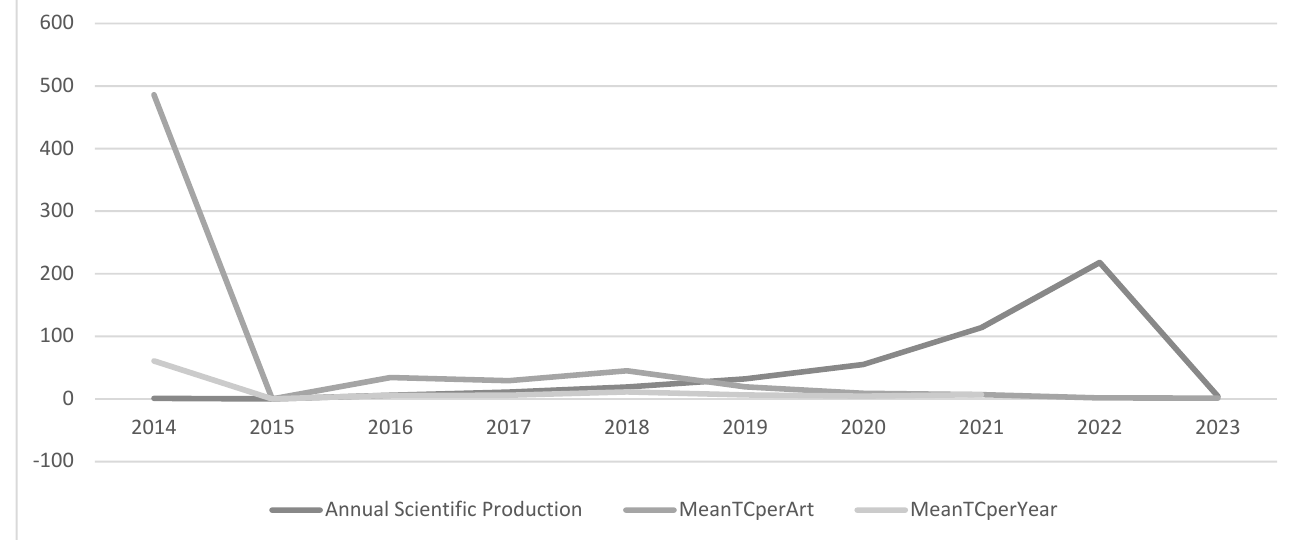
Figure 2. Annual research growth (TCPY: Total citation per year, TCPA: Total citation per article). Source: Scopus/Biblioshiny (Own elaboration).